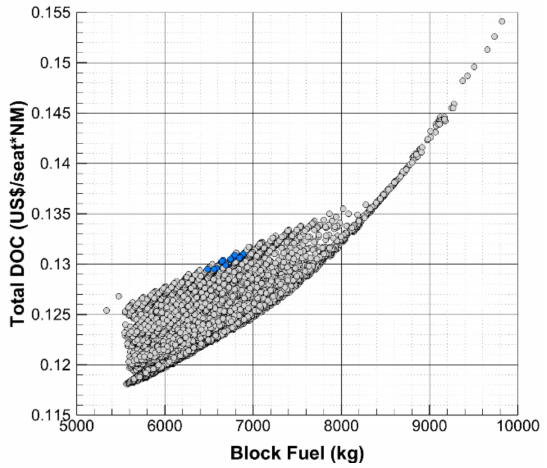
Figure 11. Total DOC versus block fuel for the rear-mounted engines configuration. Blue circles represent the solutions compliant with the imposed set of constraints.